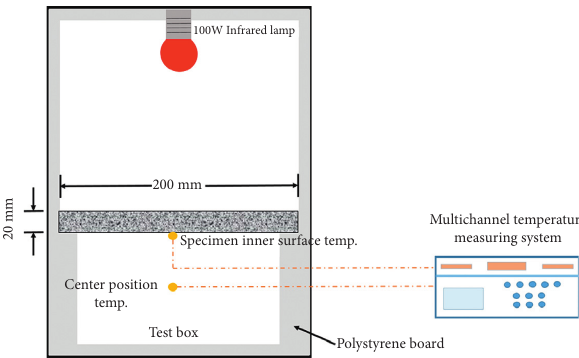
Figure 2: Schematic illustration of the self-designed heating